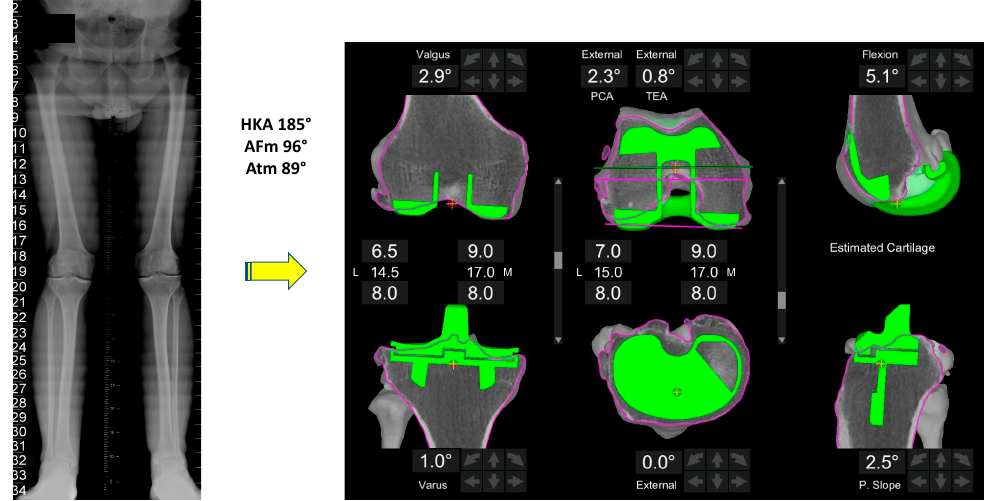
Figure 2. Typical individualized plan for a valgus morphotype knee. A typical FA plan for a valgus